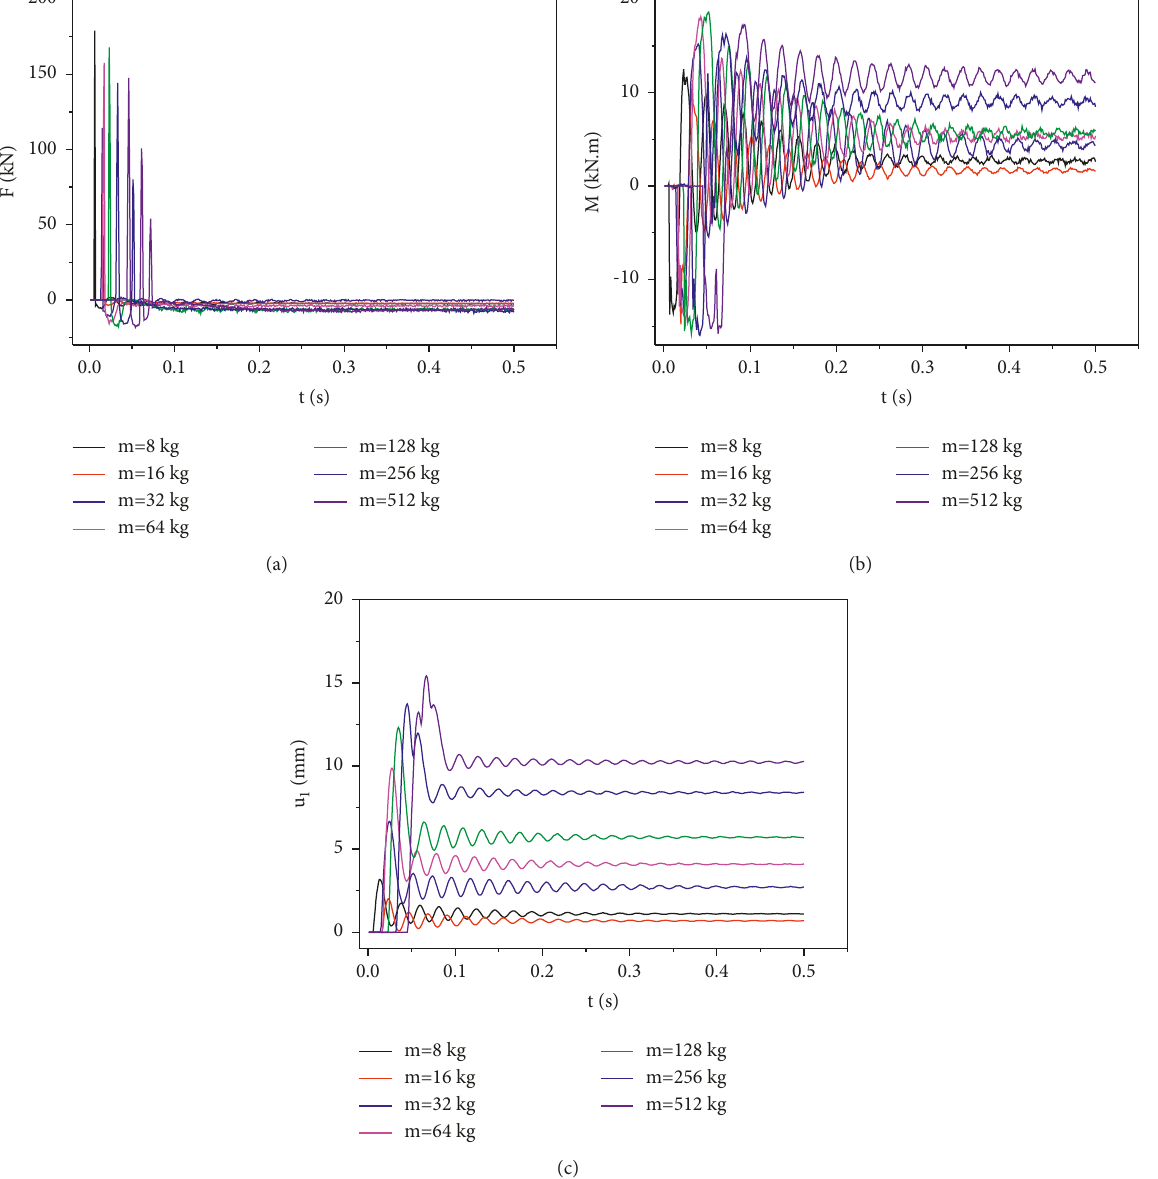
Figure 11: Dynamic response when Ek � 0.32kJ. (a) F- t ; (b) M- t ; (c) u1- t